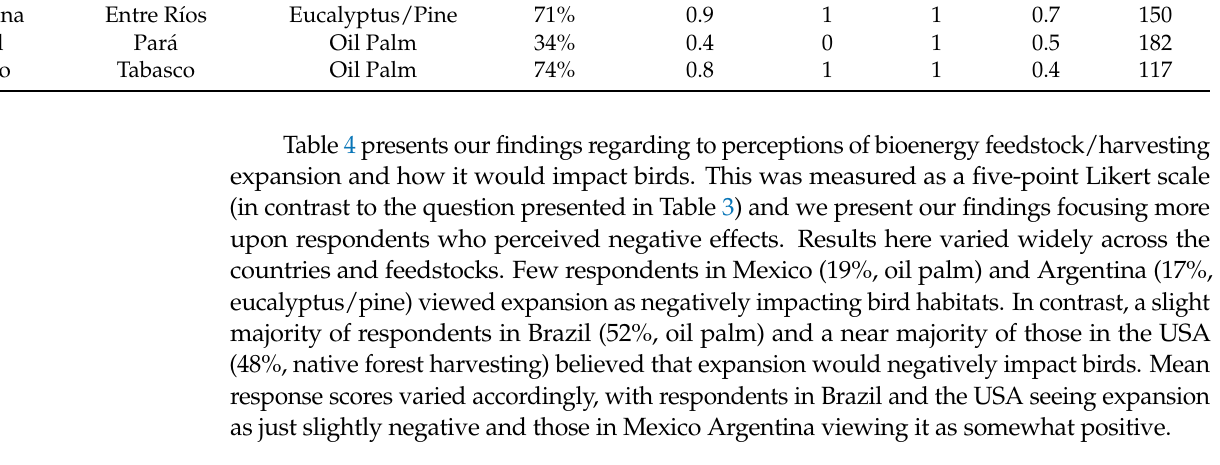
Table 4. Responses to the statement “The expansion of bioenergy feedstock cultivation or harvesting in your area would impact birds [very negatively . . . very positively].” † Likert Scale: 1 = Very negatively, 5 = Very positively.